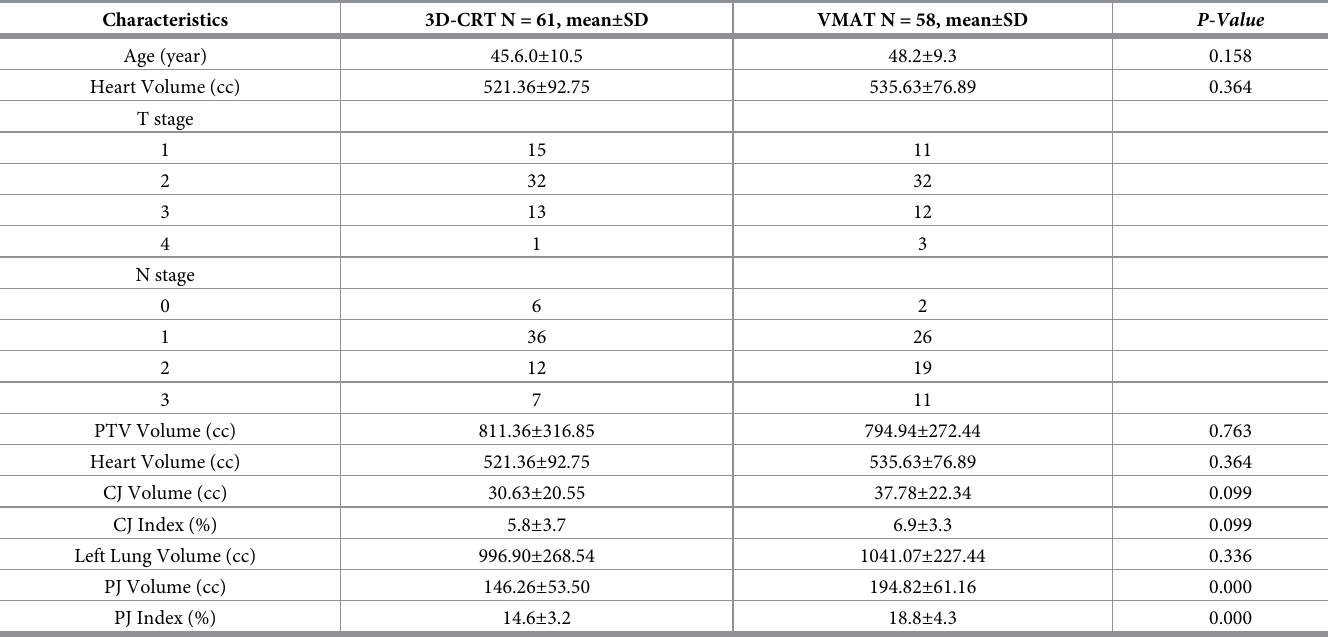
Table 1. Characteristics of patients treated with 3D-CRT and VMAT.